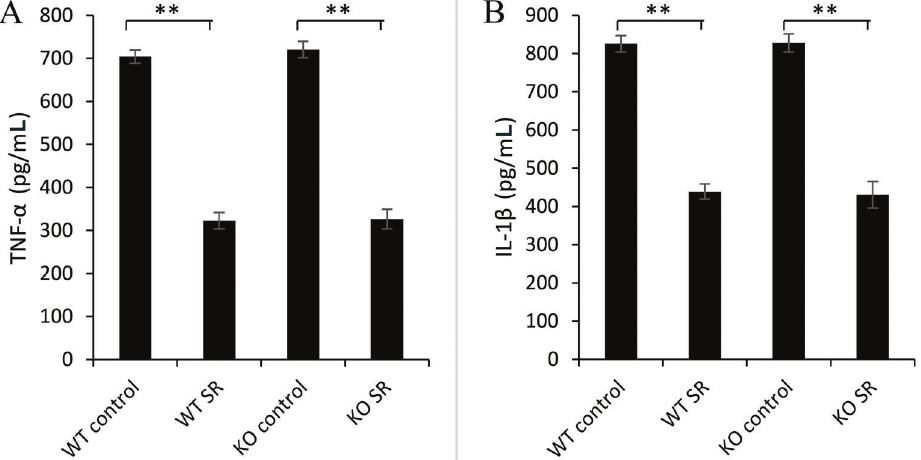
Figure 4. Serum levels of tumor necrosis factor (TNF)- a ( A ) and interleukin (IL)-1 b ( B ) obtained by ELISA. Data are reported as means ± SD. **P o 0.01 (ANOVA). SR: strontium ranelate; WT: wild type; KO: